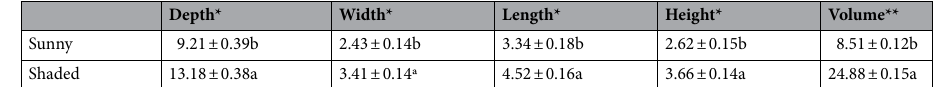
Table 2. Depth, width, length, height and volume of the initial chamber of Atta sexdens (Hymenoptera: Formicidae) nests in sunny and shaded environments. Multiple comparison test results. *Averages followed by the same letter, per column, do not differ by Tukey’s test (α = 0.05). **Medians followed by the same letter, per column, do not differ by Dunn’s test (α =